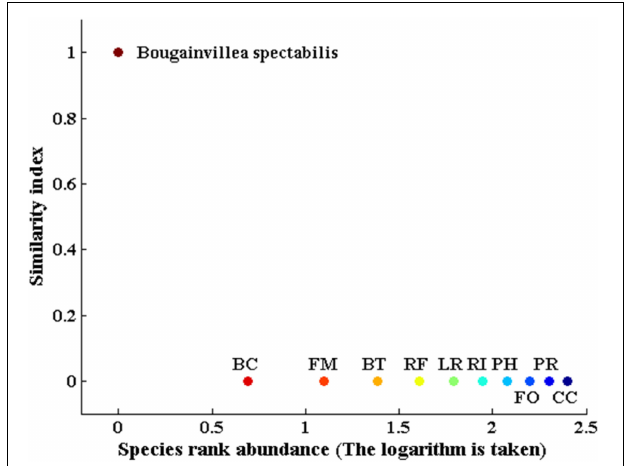
FIGURE 2 | Native plant species selection result based on our native plant species selection program. This result uses a similarity index to determine the functional trait similarity between each of the 11 candidate native plant species (i.e., BS, Bougainvillea spectabilis ; BC, Bombax ceiba ; FM, Ficus microcarpa ; BT, Bridelia tomentosa ; RF, Radermachera frondosa ; LR, Lepisanthes rubiginosa ; RI, Rhaphiolepis indica ; PH, Pterospermum heterophyllum ; FO, Fissistigma oldhamii ; PR, Psychotria rubra ; CC, Cudrania cochinchinensis ) and the invasive exotic plant species ( Leucaena leucocephala ). A higher similarity index indicates higher similarity between the native plant species and the invasive exotic plant species.